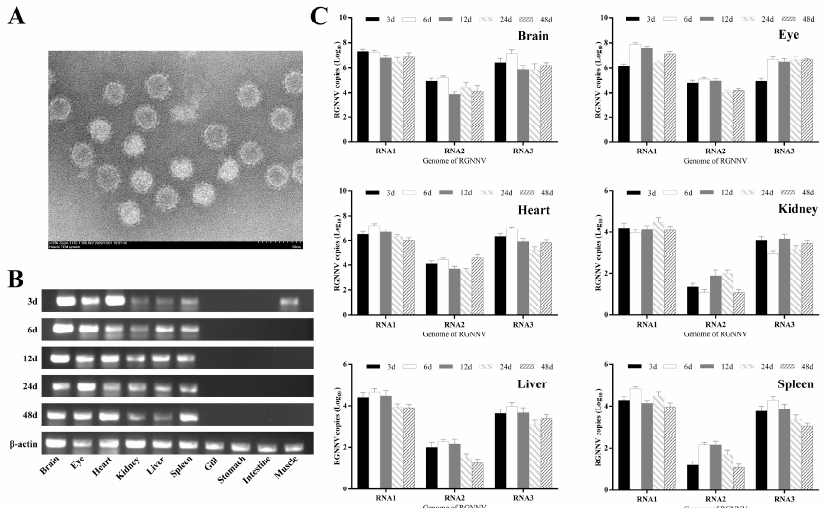
Figure 6. The changes in viral genome expression in tissues and organs of grouper larvae at different time points after NNV infection. ( A ) Electron micrograph of negatively stained virus particles pel- leted from infected SSN-1 cells culture fluid which injected grouper larvae. ( B ) RT-PCR results of B2 protein gene expression in tissues of virus-infected grouper larvae; ( C ) qRT-PCR technique to detect changes in RNA1, RNA2 and RNA3 genome expression contents in tissues of virus-infected larvae.